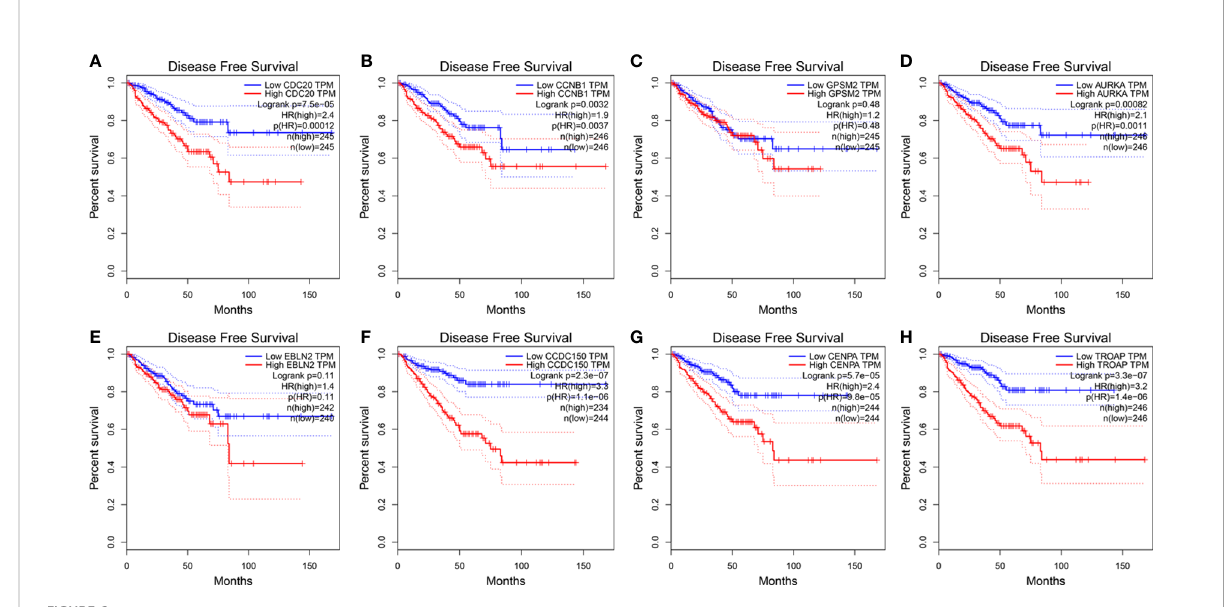
FIGURE 6 The expression of vinblastine resistance-related genes with PCa patients DFS status from TCGA database. (A) CDC20 (B) CCNB1 (C) GPSM2 (D) AURKA (E) EBLN2 (F) CCDC150 (G) CENPA (H) TROAP